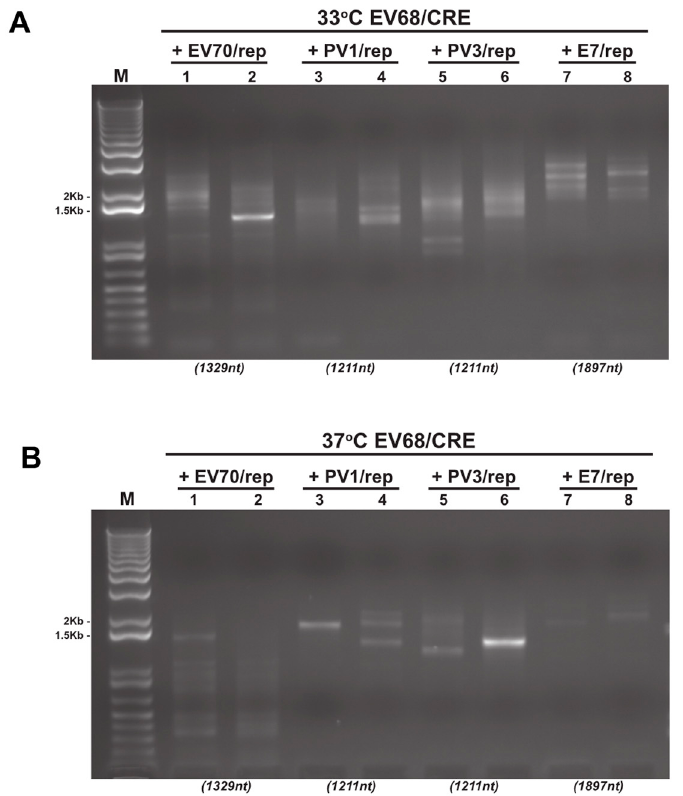
Figure 3. Reverse-transcription PCR analysis of CRE-REP assay samples. Example gel electrophoresis analysis of total RNA isolated and amplified by RT-PCR from CRE-REP assays. In this example, we show results from both 33 ◦ C ( A ) and 37 ◦ C ( B ) following co-transfection of the EV68/CRE acceptor template with either a species B, C, or D donor template. Lanes are numbered 1–8 for reference. Numbers in brackets below gel images are the expected sizes for a precise recombinant of each assay template